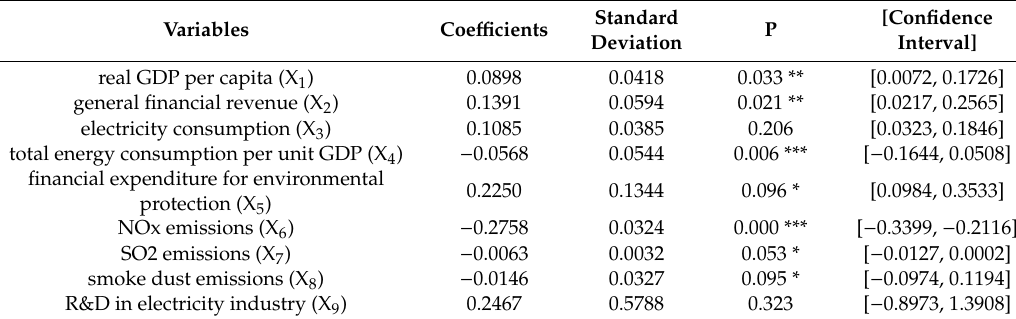
Table 8. Results of the Tobit regression